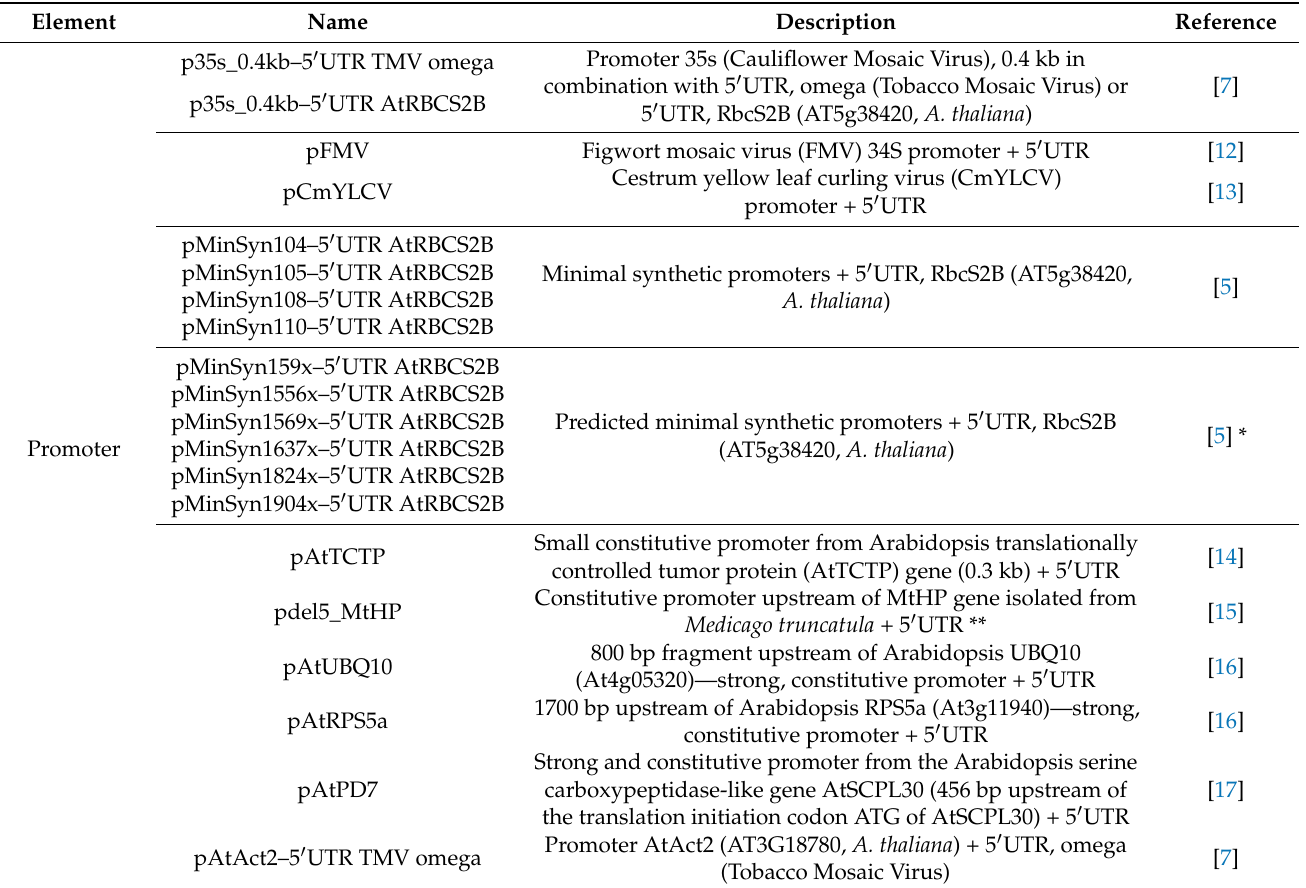
Table 1. Promoters and terminators used in this study.